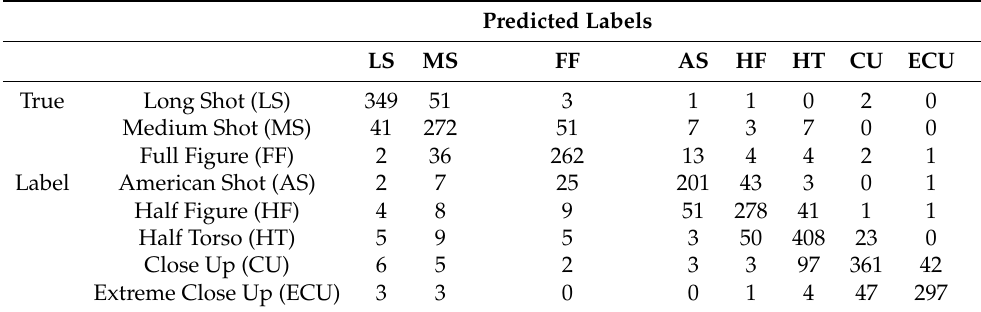
Table 10. Confusion Matrix of a VGG-16 trained on the augmented Original Dataset with the flip on the y-axis and zoom range = 0.1, i.e., Scenario 2.